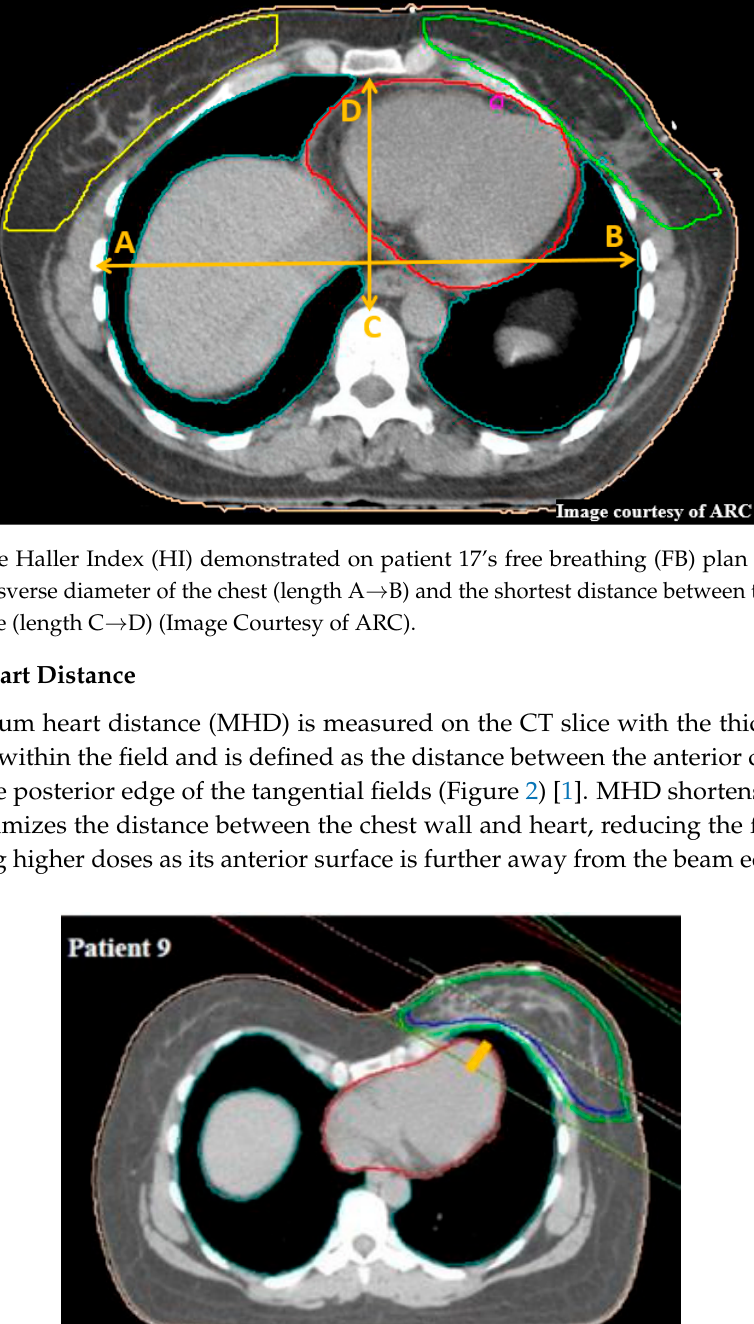
Central lung distance (CLD) is defined as the perpendicular distance from the posterior edge of the field border to the anterior chest wall (lung interior). The length is measured at the central axis of the tangential field in the digitally reconstructed radiograph (DRR) (Figure 3). Chest wall separation (CWS) is defined as the measurement between the most posterior field edges of the beam from the medial and lateral tangents of the non-diverging beam pair, measured at the centre of the field on the cranio-caudal axis (Figure 4) [29]. Figure 3. Central lung distance (CLD) (yellow) measured across FB (left) and DIBH (right) plans for patient 3 was identical (Image Courtesy of ARC).